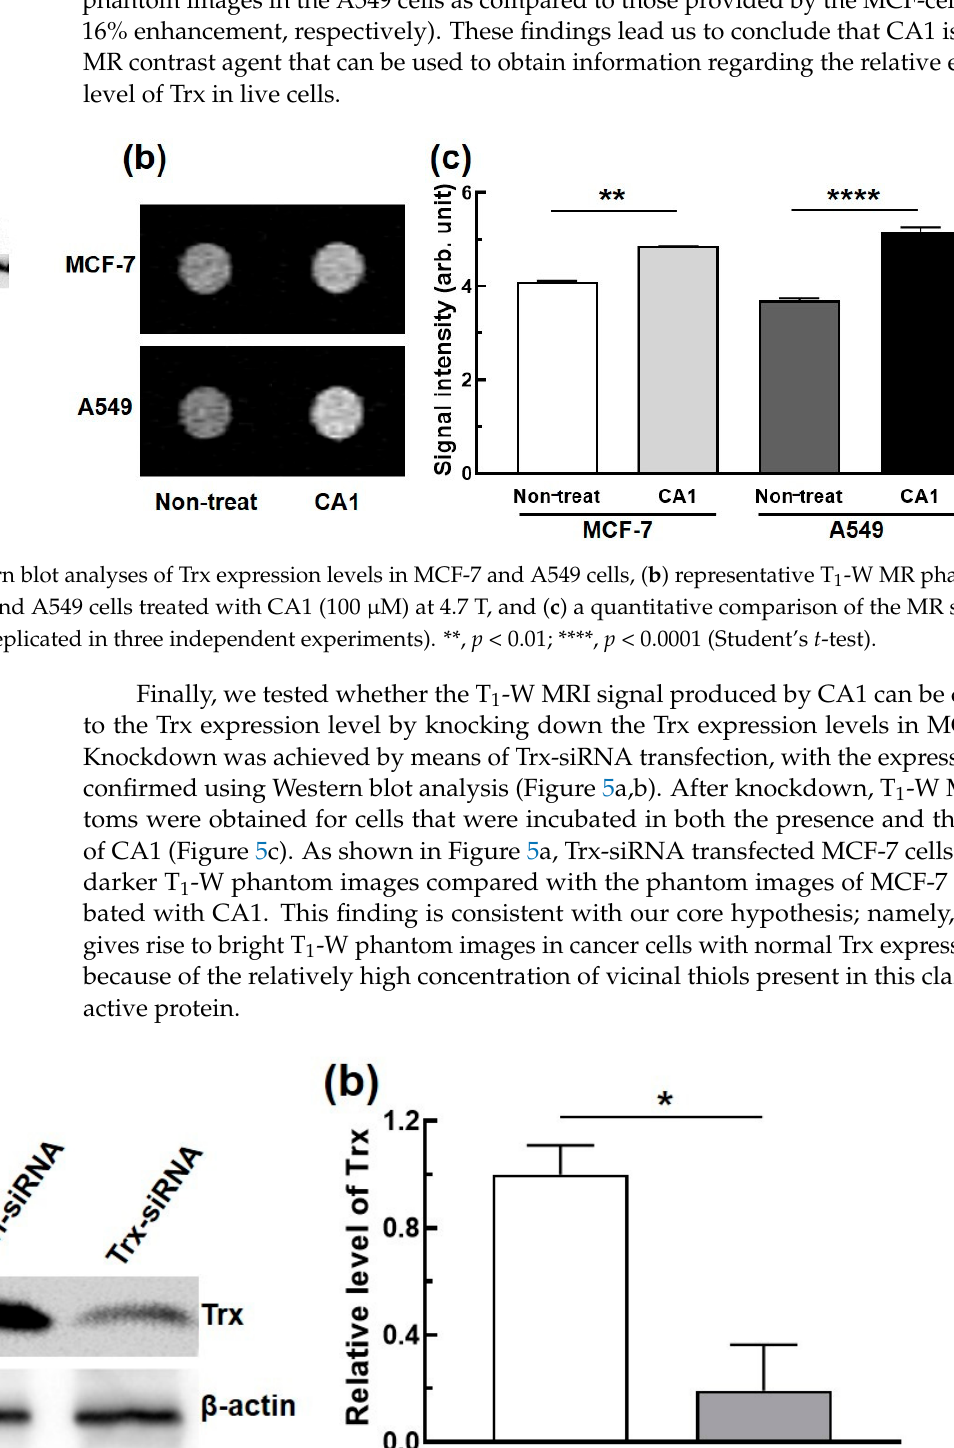
Figure 5. ( a ) Western blot analyses of Trx expression levels in MCF-7 cells transfected with Trx-siRNA (3 µM, 48 hrs) compared to those of control siRNA (Ctrl-siRNA) and ( b ) a corresponding quantitative comparison of Trx expression (n = 2). ( c ) A representative T 1 -W MR phantom image of MCF-7 cells transfected with Trx-siRNA or Ctrl-siRNA and then treated with CA1 (100 µM) at 200 MHz at room temperature, and ( d ) a comparison of the corresponding signal intensities (n = 3). *, p < 0.05; **, p < 0.01 (Student’s t-test ). A quantitative comparison of the T 1 -W signal intensities (cf. Figure 5d) revealed sim- ilarly low intensities for both the control MCF-7 cells and the Trx-siRNA transfected MCF- 7 cells in the absence of the MR contrast agent CA1. In contrast, in the presence of CA1 (100 µM), the MR signal intensity of the MCF-7 increased significantly compared to what was seen for the untreated MCF-7 cells. Notably, the T 1 -W MR intensity of the Trx-siRNA transfected MCF-7 cells remained relatively low under identical CA1 treatment condi- tions. These results are taken as further evidence that CA1 is a highly sensitive MRI probe that may be used to detect the level of vicinal thiol motifs in proteins such as Trx and can be employed without any obvious interference from other entities that might be present in live cells. 3. Materials and Methods 3.1. Materials and Instrumentation Arsanilic (TCI, Tokyo, Japan), phenyl hydrazine (TCI), 1,2-ethanedithiol (Sigma-Al- drich, Munich, Germany) diethylenetriamine (Sigma-Aldrich), phthalic anhydride (Sigma-Aldrich), benzyl chloroformate (Sigma-Aldrich), hydrazine (TCI, Tokyo, Japan), tert-butyl bromoacetate (Sigma-Aldrich), benzyl bromoacetate (Sigma-Aldrich), N-BOC